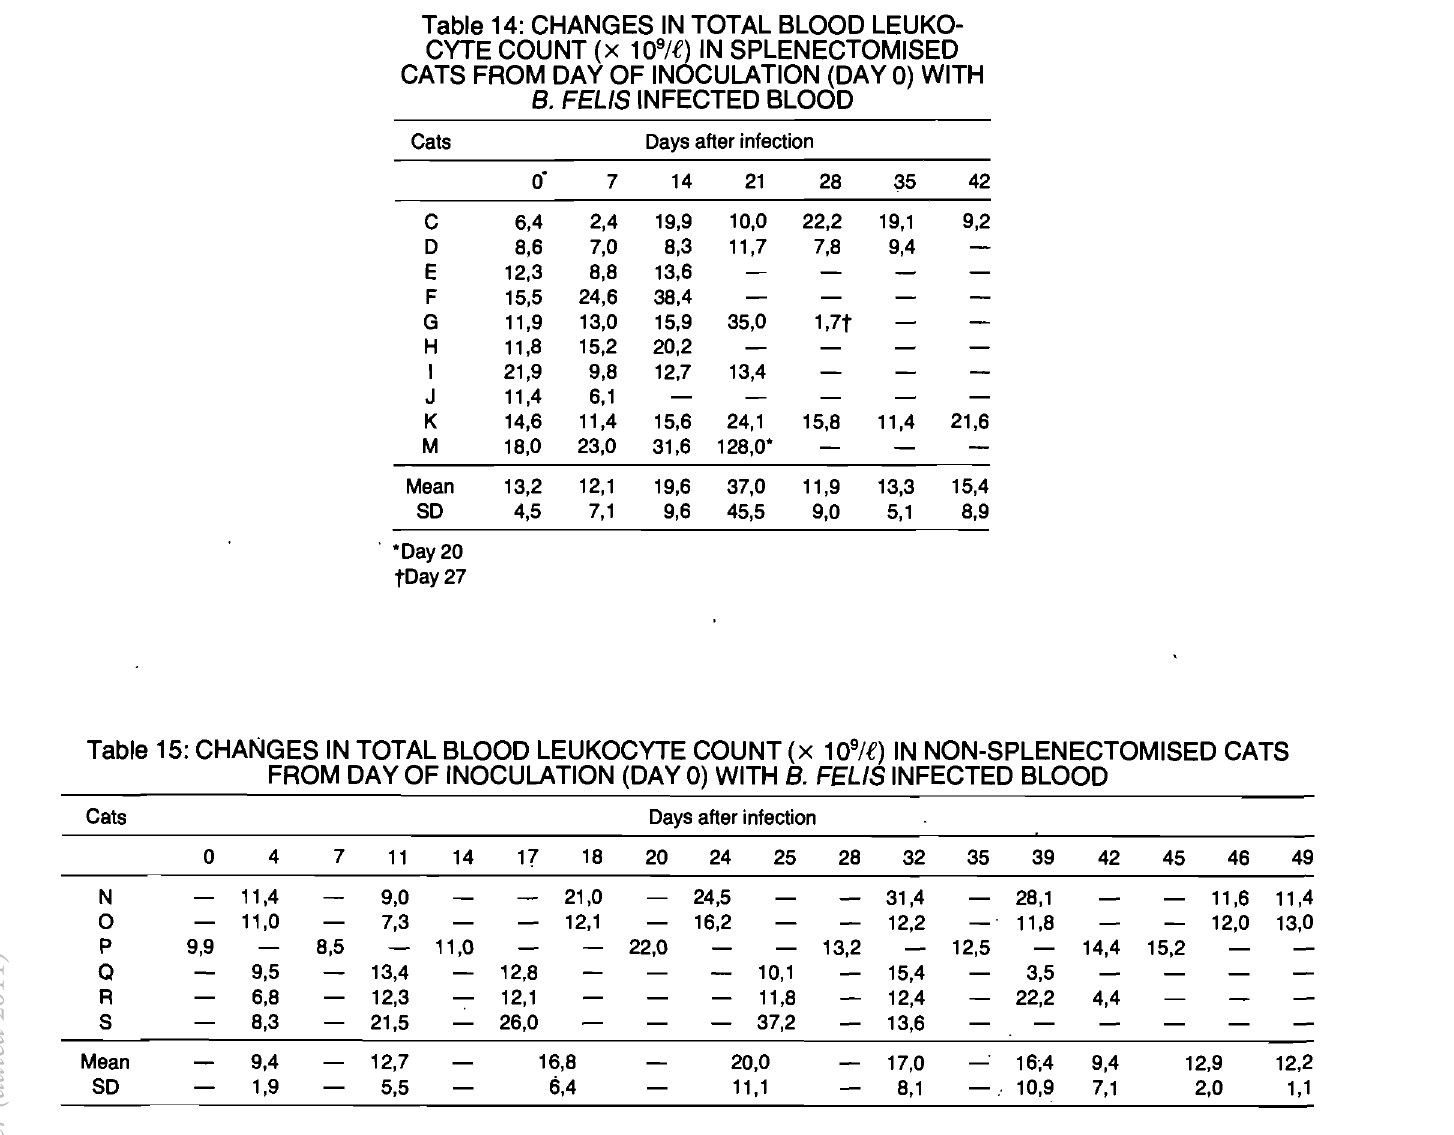
Table 16: HAEMATOLOGY PRE-SPLENECTOMY Table 17: INITIAL (I) AND RECOVERY (R) Ht AND AND 14 DAYS PQST-SPLENECTOMY Hb (gfdt') LEVELS qF. FIELD CASES OF B.